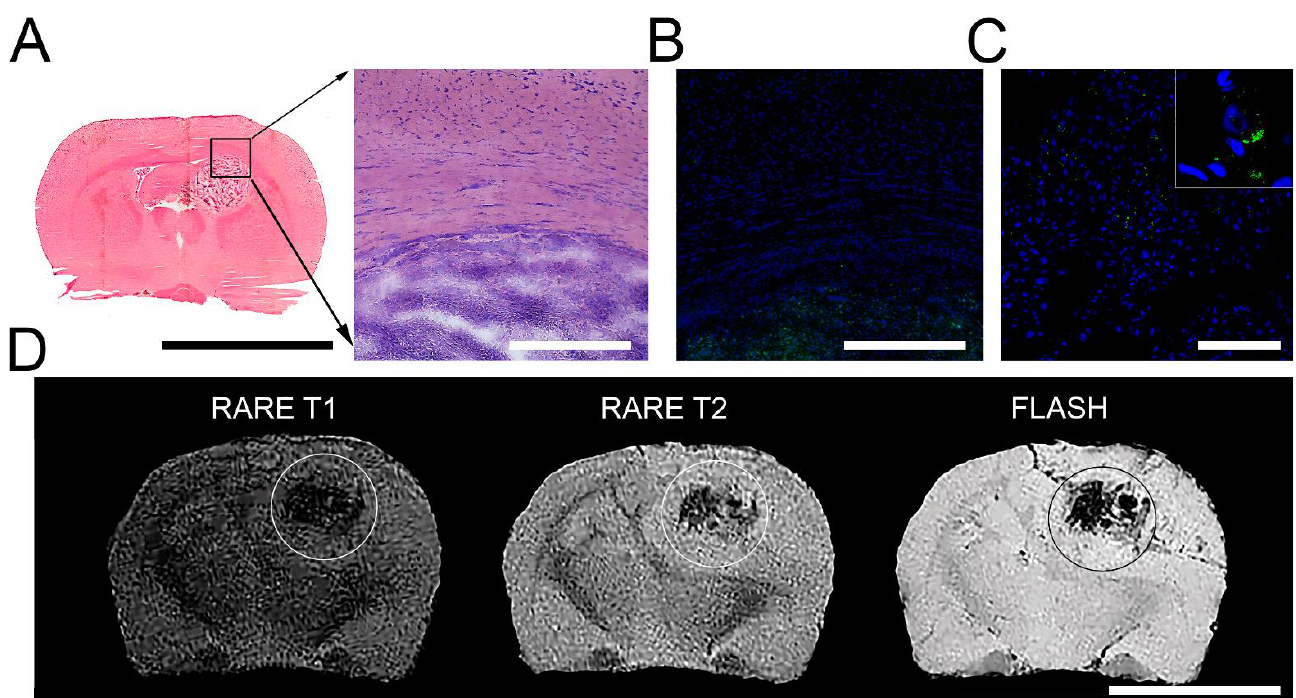
Figure 3. Evaluation of rat MSCs tropism to glioma in vivo. ( A ) Frozen section of animal brain with glioma (black square). Scale bar, 10 mm. Borders of glioma and brain tissue at high magnification. H and E staining. ( B ) Fluorescence microscopy images. Detection of the glioma area. Nuclei were stained with DAPI (blue) and GFP-positive C6 cells (green). Scale bars, 400 µm. ( C ) Confocal microscopy image. Cryosection of brain with glioma following 24 h after intravenous administration of the SPION-labeled MSCs. Scale bars, 100 µm. ( D ) Magnetic resonance images of the brains of glioma-bearing animals following 24 h after intravenous administration of the SPION-labeled MSCs. Images were obtained at RARE-T1, RARE-T2, and FLASH regimens. Scale bar, 10 mm.